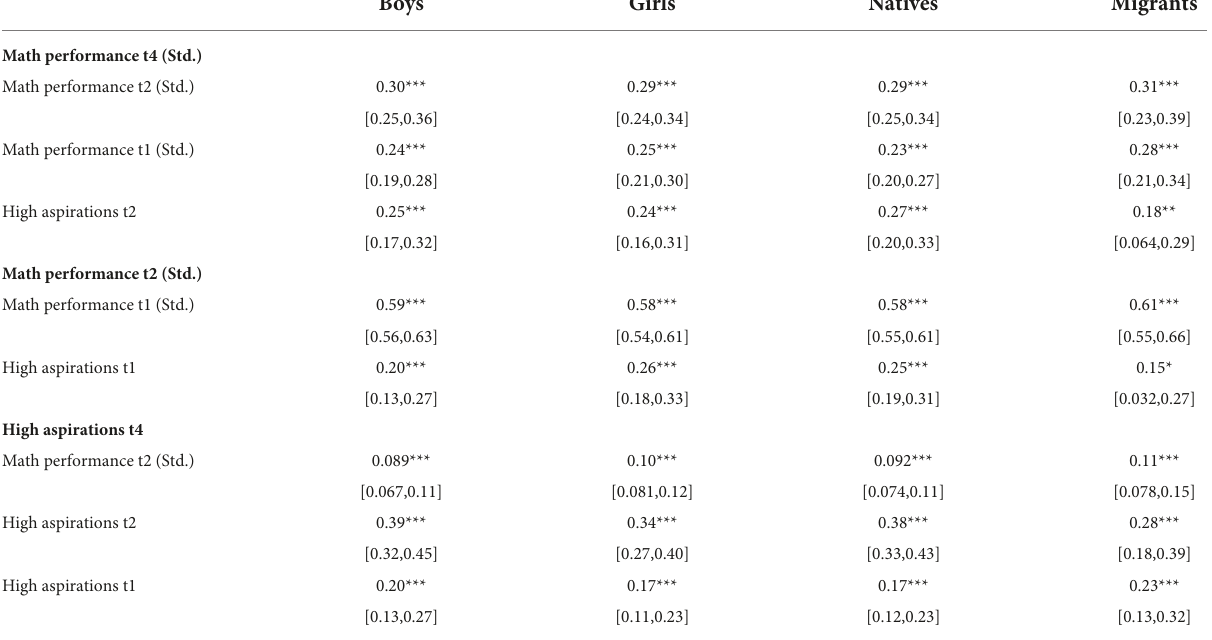
TABLE A2 Robustness checks (subgroup analyses for the cross-lagged panel model). Boys Girls Natives